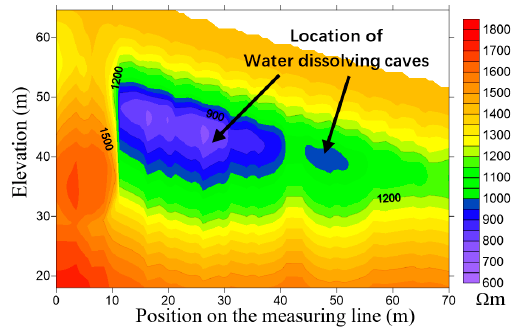
Figure 11. Apparent resistivity imaging of the water dissolving caves by the cross-loop design. The shape and location of the low resistance water dissolving caves are accurately displayed.